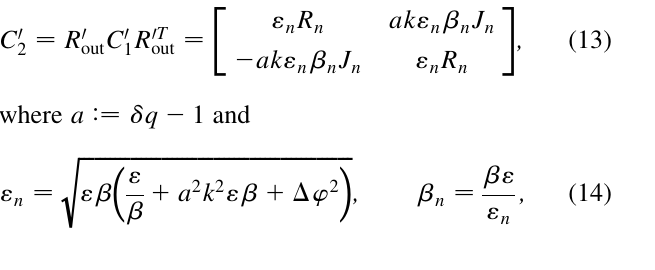
The parameter t is introduced to quantify the interplane coupling. If t defined